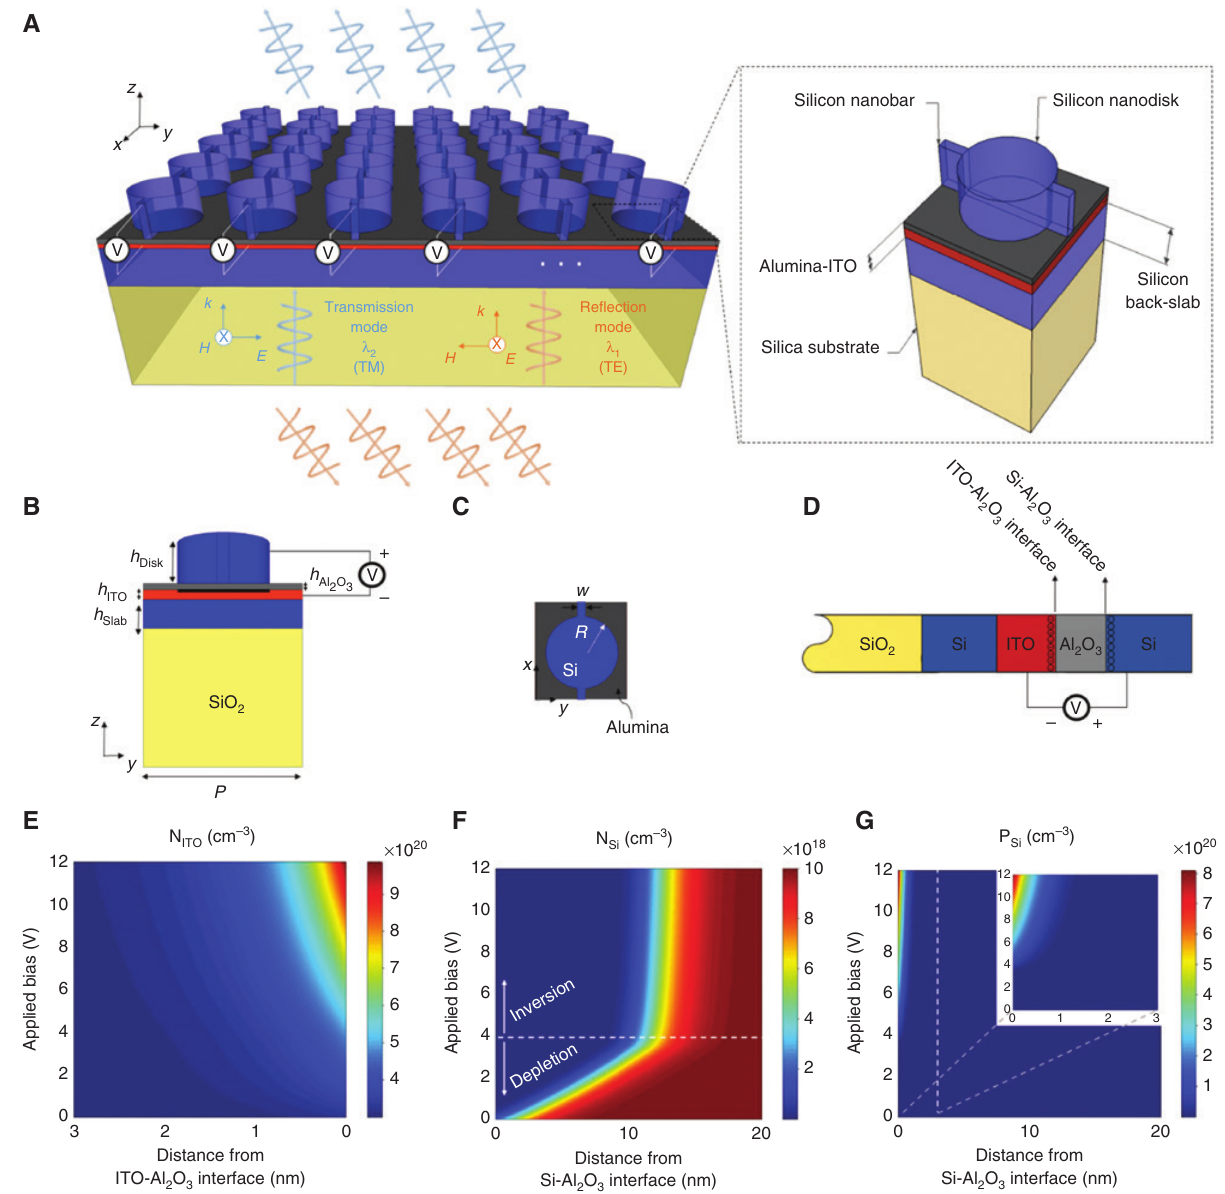
Figure 1: Geometry and electrostatic characteristics of the proposed tunable dual-mode metasurface. (A) Schematic overview of tunable dual-mode metasurface including a periodic array of ITO-integrated Si nanodisks located on top of a high- index Si slab and a SiO substrate. This metasurface is capable of performing wide phase modulation over both reflection and transmission 2 modes at operating wavelengths of λ and λ by controlling the level of applied voltages. (B) Cross-sectional view ( y - z plane) and (C) top 1 2 view ( x - y plane) of the proposed ITO-assisted SIS unit cell with R = 320 nm, P = 700 nm, h = 12 nm. (D) The biasing scheme and formation of carrier accumulation/depletion at ITO-Al h Al 2 O 3 voltage is directly applied between the ITO layer and the highly n-type doped Si nanodisk with a carrier density of 1 × 10 19 cm −3 . (E) Electron carrier concentration of the ITO active layer as functions of applied bias voltage and distance from ITO-Al hole densities in the Si active layer as functions of applied bias voltage and distance from the Si-Al